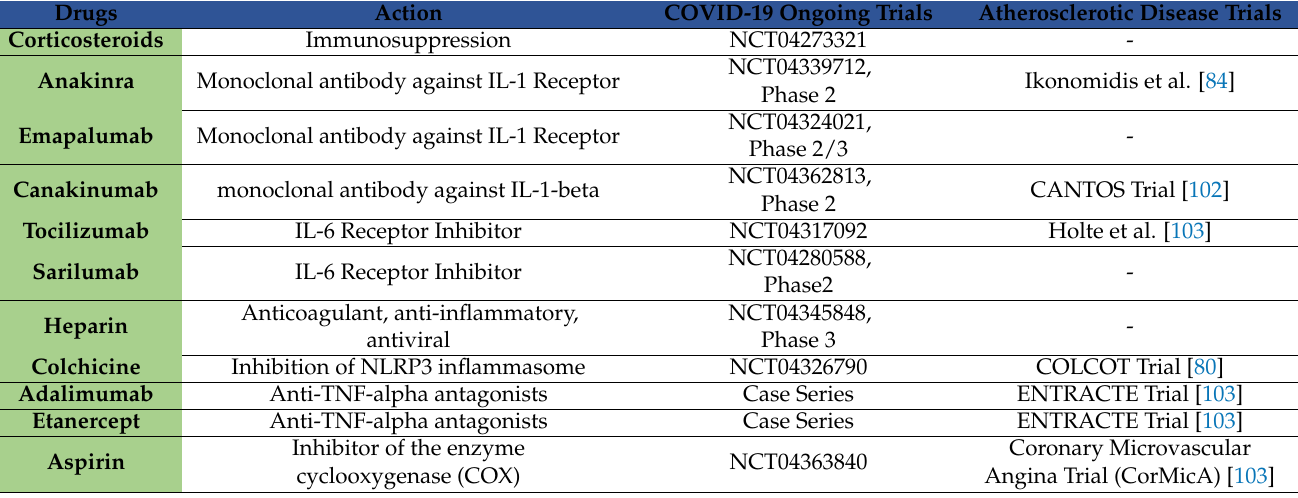
Table 3. Beneficial anti-inflammatory therapeutic